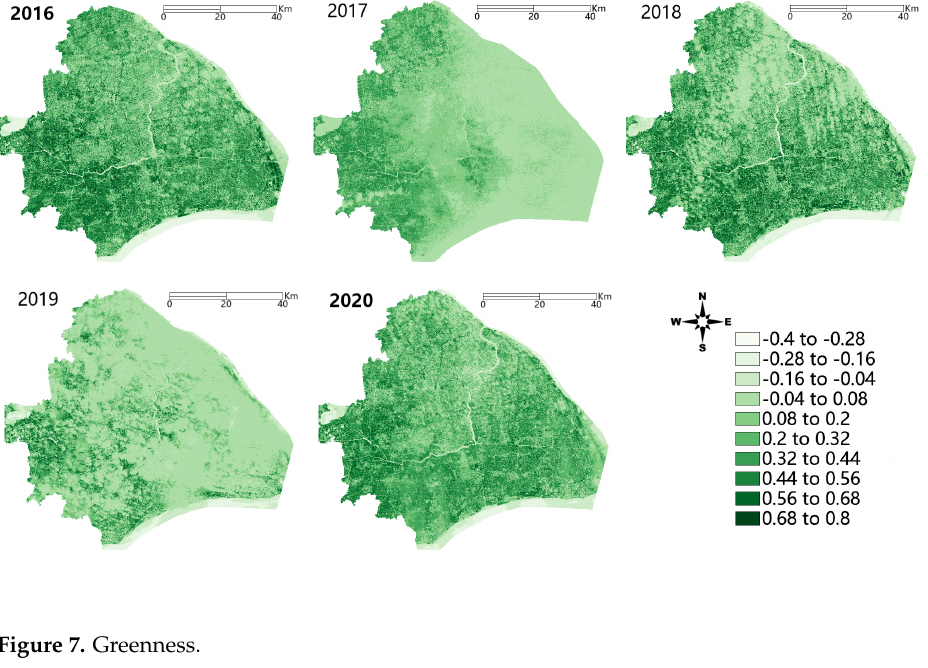
Figure 7. Greenness.